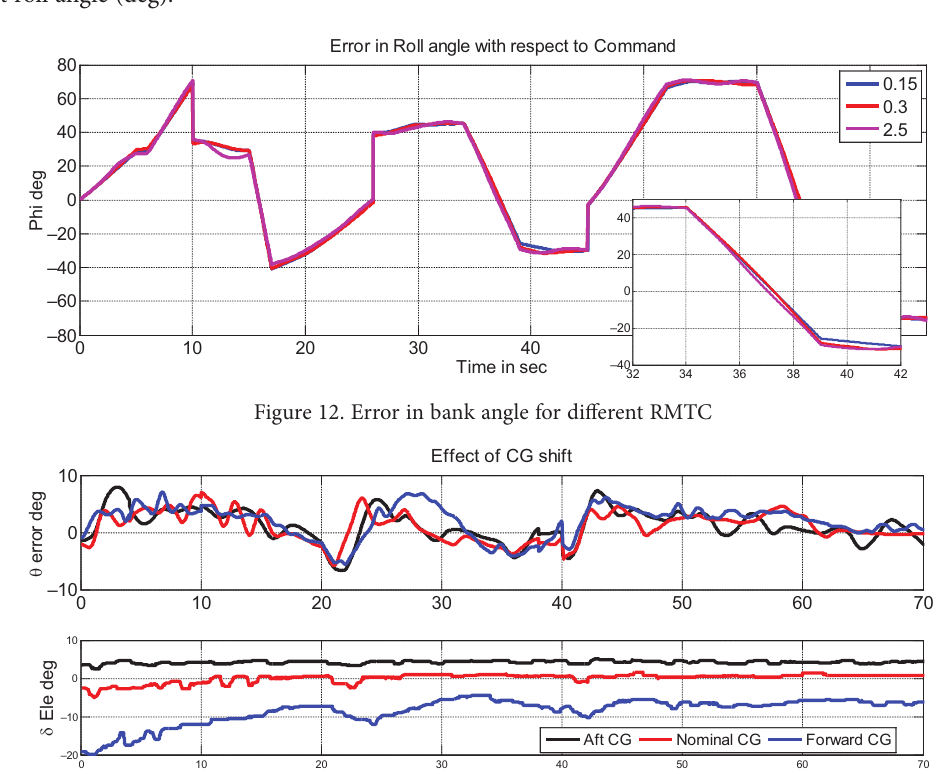
Figure 11. Pilot tracking the Roll command